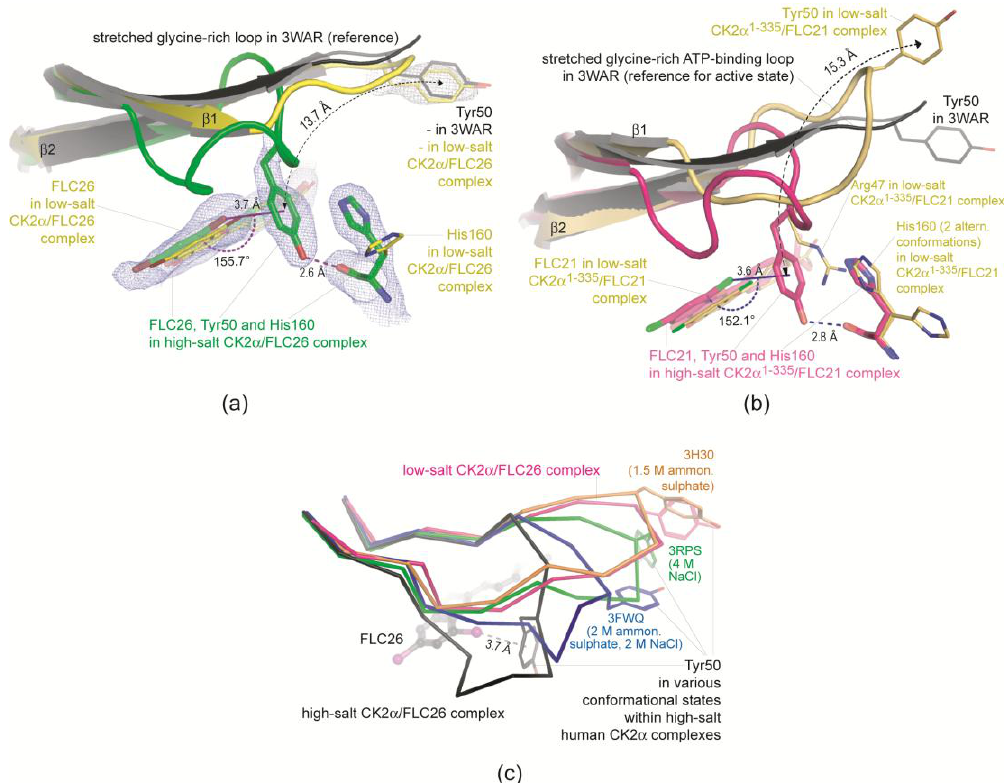
Figure 3. Formation of a kosmotropic-salt supported π-halogen bond between either FLC21 or FLC26 and CK2α 1–335 . ( a ) FLC26: Under high-salt crystallization conditions Tyr50 at the tip of the ATP-binding loop bends down to the Br8 atom of FLC26 (π-halogen bond) and His160 (hydrogen